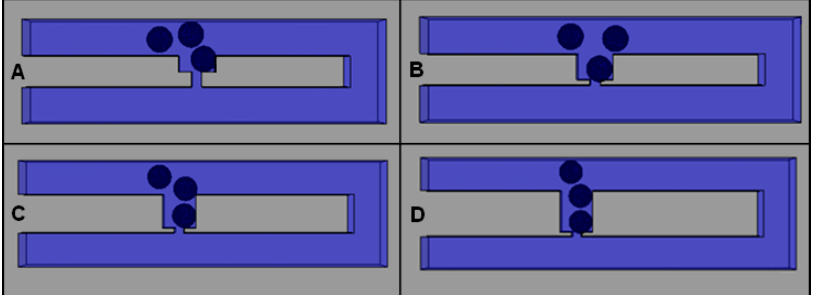
Figure 7. Cell trapping results for the optimization of different L Trap values: ( A ) 3 μ m; ( B ) 5 μ m; ( C ) 7 μ m; and ( D ) 9 μ m.